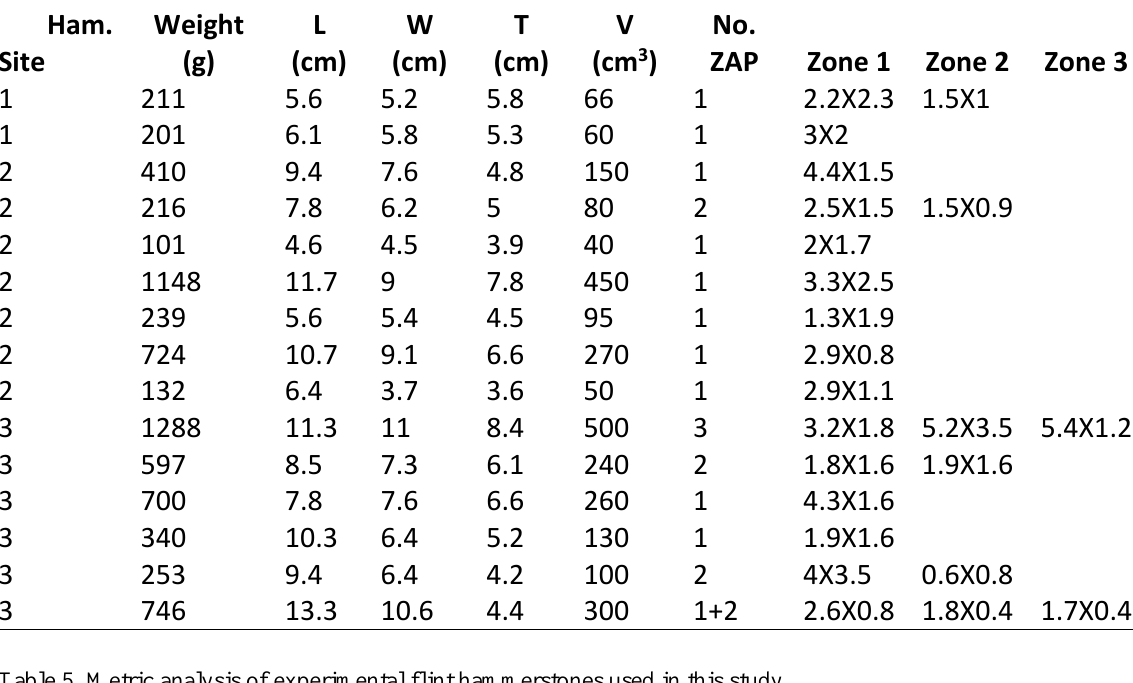
Table 5. Metric analysis of experimental flint hammerstones used in this study. Exp.